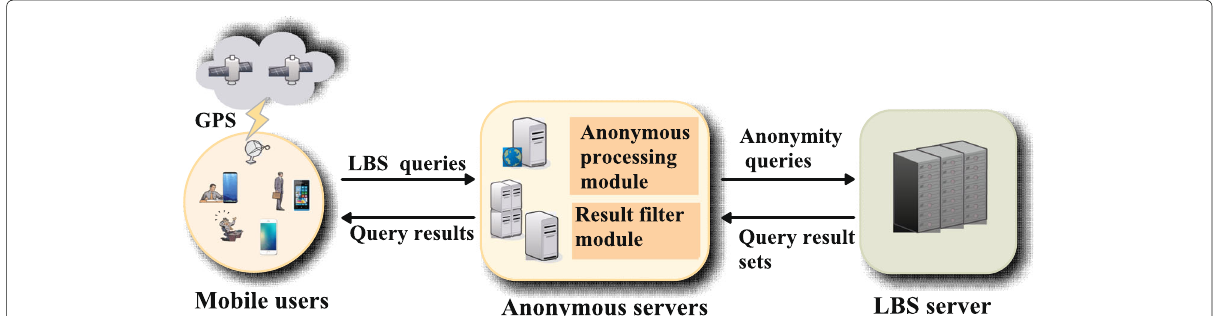
Fig. 1 Central server architecture. It consists of mobile users, LBS servers, and location anonymous server. As the core of the whole architecture, the anonymous server is responsible for processing anonymously the information such as the users’ real location, filtering the candidate query result set returned by the service provider and then returning them to the users who send LBS